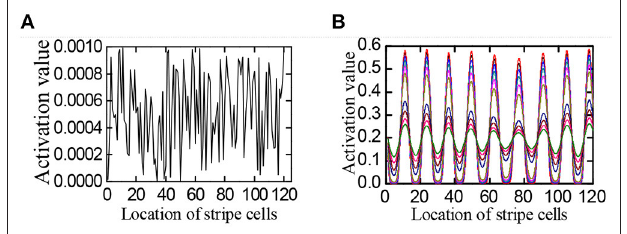
FIGURE 11 | The figure shows the firing point of a single stripe cell in the trajectory. Striped cells neural plates with different priority directions can form patterns in different